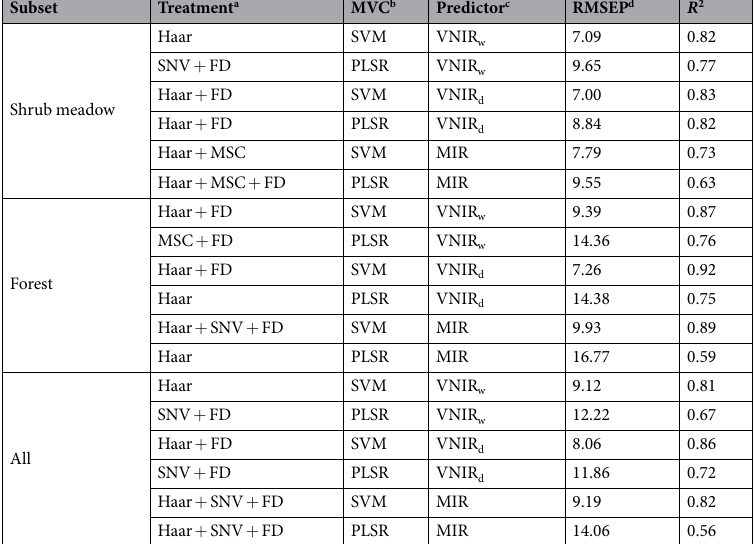
Subset Treatment a MVC b Predictor c RMSEP d R 2